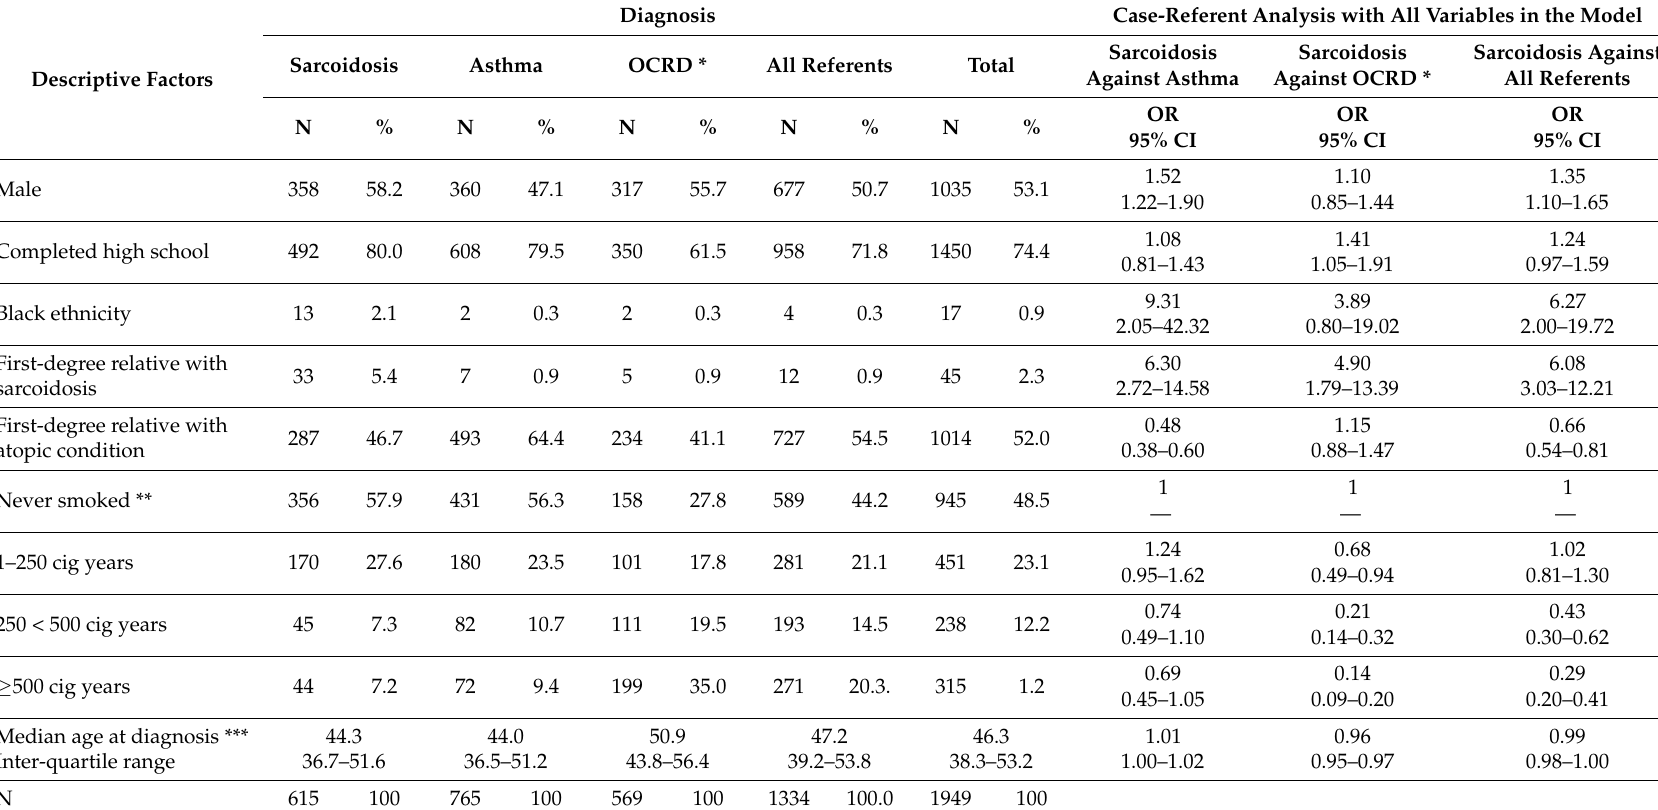
Table 1. Description of the sample and the contribution of descriptive factors to multivariable logistic regression models comparing cases of sarcoidosis